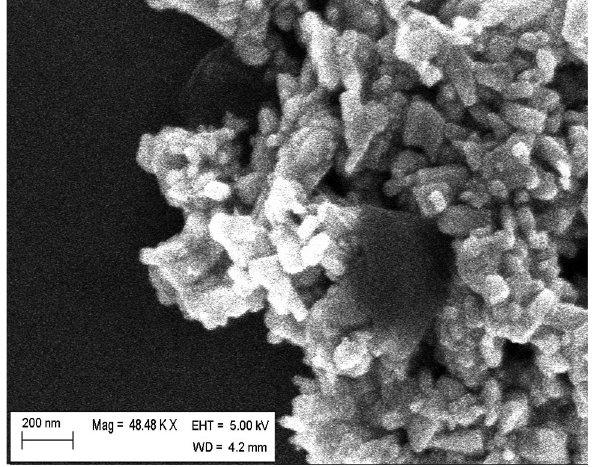
Fig. 6 Percentage of HA degraded by photo-Fenton type reactions under solar irradiation for 3 h in pond